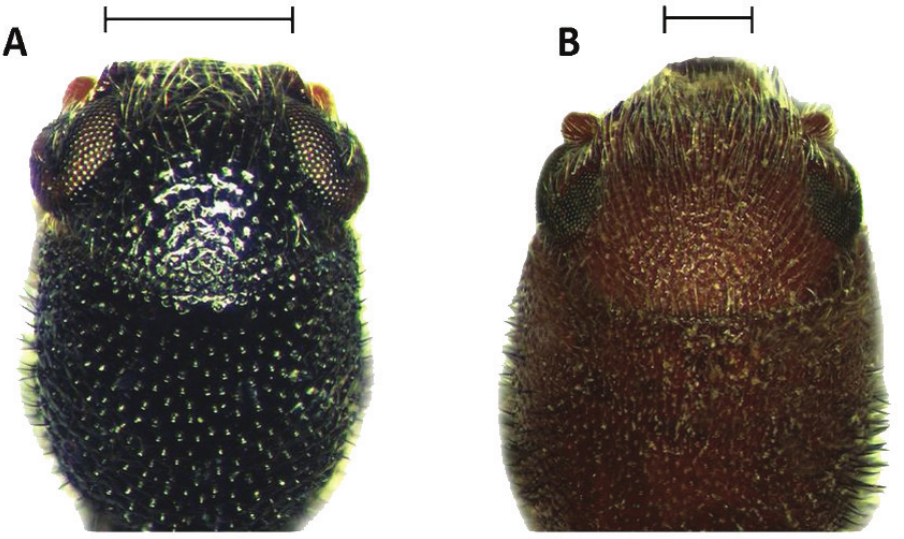
Figure 14. Head of: A Neocallotillus elegans B Callotillus eburneocinctus . Bars indicate width of frons.